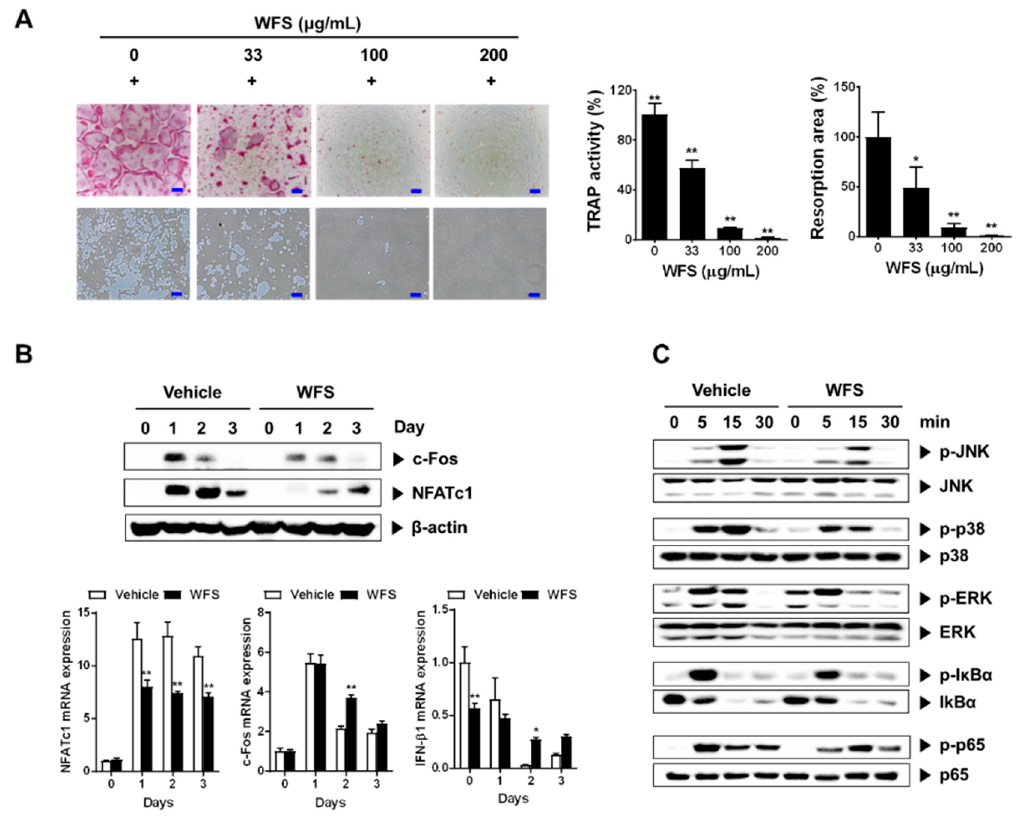
Figure 2. Inhibitory e ff ects of WFS on RANKL-induced osteoclast di ff erentiation of bone marrow-derived macrophages (BMMs). ( A ) Inhibition of osteoclast di ff erentiation by WFS. Tartrate-resistant acid phosphatase (TRAP) staining (left, top), resorption pits (left, bottom), TRAP activity (middle), and resorption area (right). ( B ) Inhibitory e ff ects of WFS on the expression of c-Fos and NFATc1. BMMs were pretreated with vehicle (distilled water) or WFS (100 µ g / mL) for 3 h and then treated with RANKL (100 ng / mL) for the indicated days. The protein and mRNA levels were determined by Western blot and real-time PCR analyses, respectively. ( C ) Modulatory e ff ects of WFS on RANKL-induced early signaling pathways. BMMs were pretreated with vehicle or WFS (100 µ g / mL) for 3 h and then treated with RANKL (100 ng / mL) for the indicated times. Cell lysates were subject to Western blot analysis. Data are representative mean ± SD of three independent experiments. * p < 0.05, ** p < 0.01 vs. control treated with vehicle. p-JNK, phospho-JNK; p-p38, phospho-p38; p-ERK, phospho-ERK; p-p65, phospho-p65; p-I κ B α , phospho-I κ B α